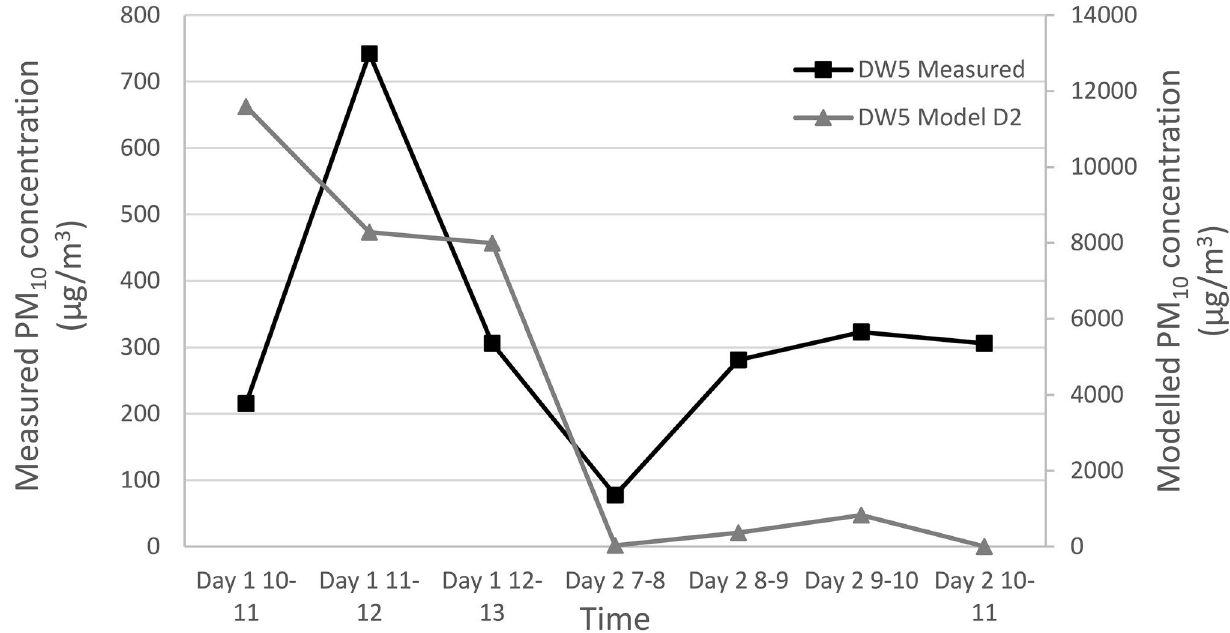
Fig. 9 PM concentrations at 5 m downwind (DW) from the drill: Measured (first y -axis) and modelled (second y 10